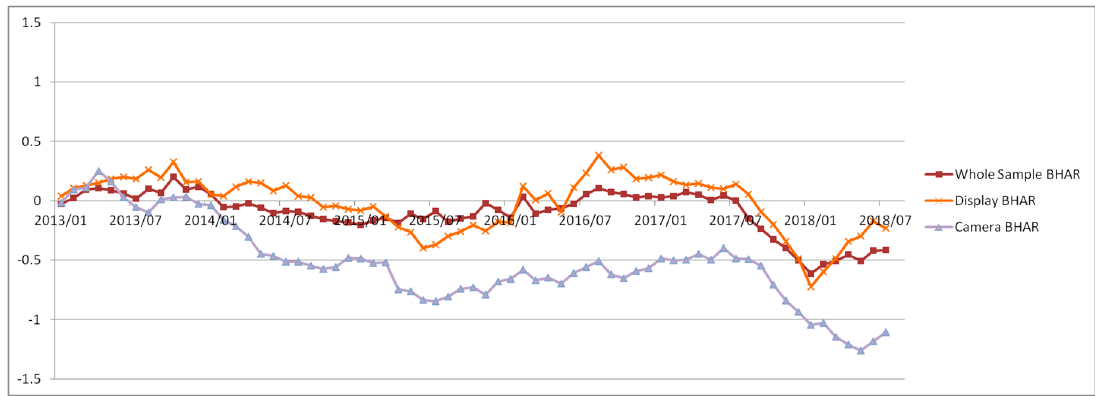
Figure 17. Average BHAR for Jan 2013-Jul 2018. Table 6. Cross-correlation of average BHARs for Jan 2013-Jul 2018.